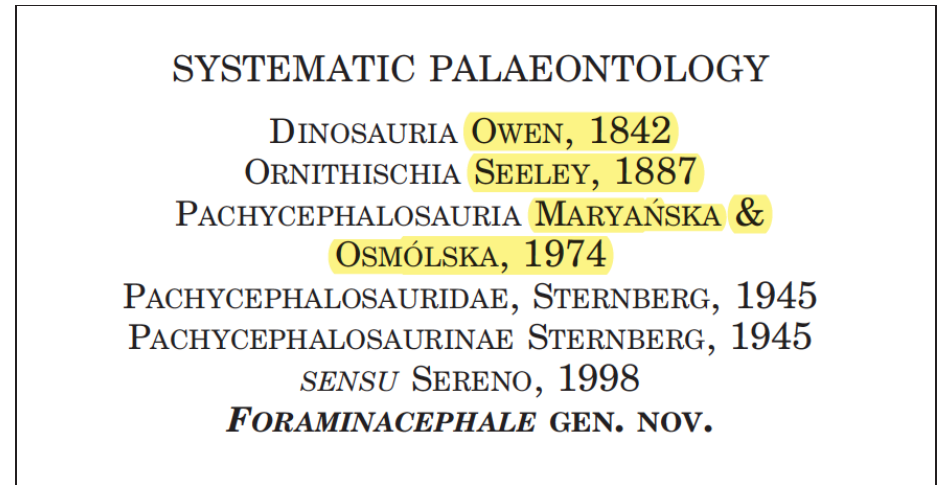
Fig. 13. The authorships highlighted in yellow are cited nowhere else in the article and yet they are listed in the references section (Schott & Evans